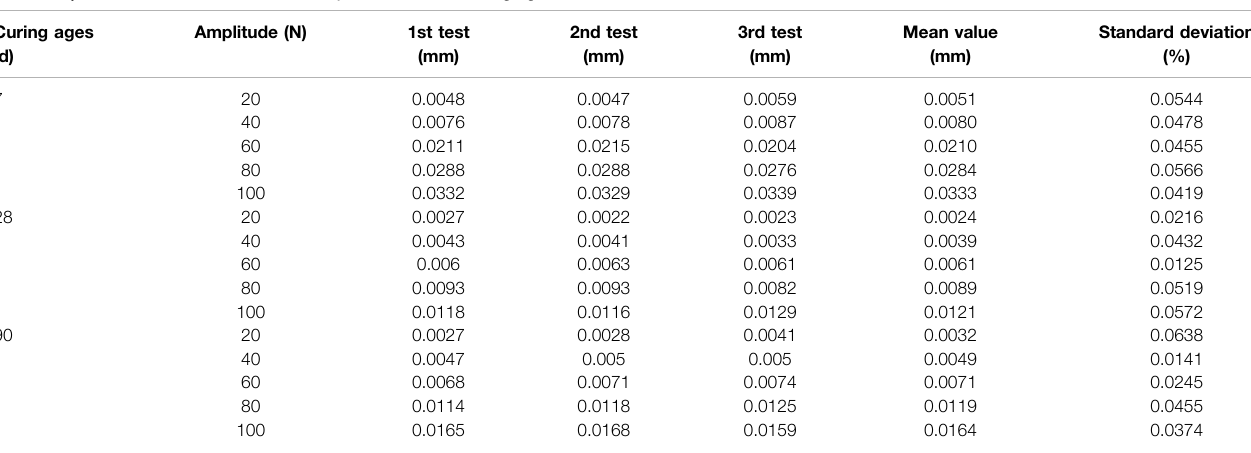
TABLE 5 | Final axial strain of solidi fi ed muddy soil at different curing ages. Curing ages